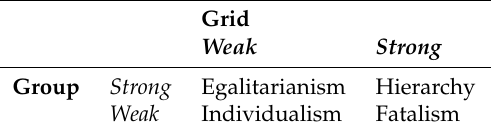
Table 3. A typology of cultures ([51],